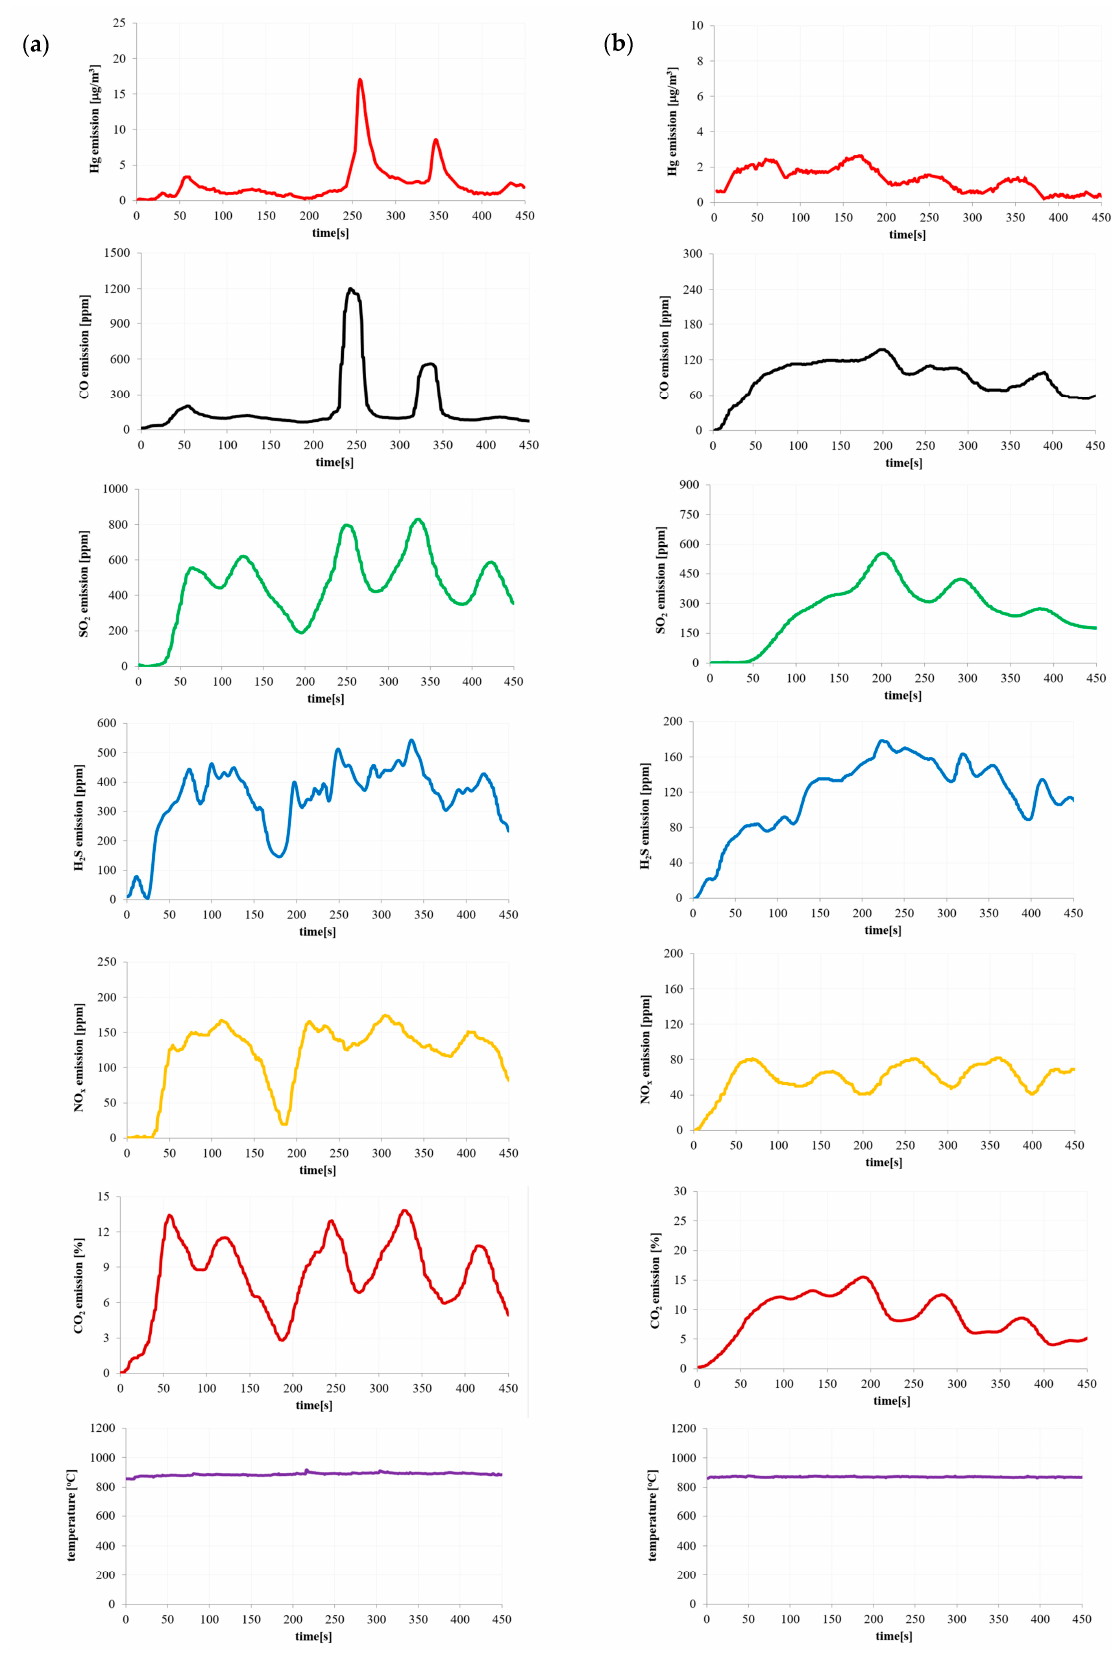
Figure 2. Emission of pollutants during ( a ) hard coal and ( b ) coal sludge combustion.